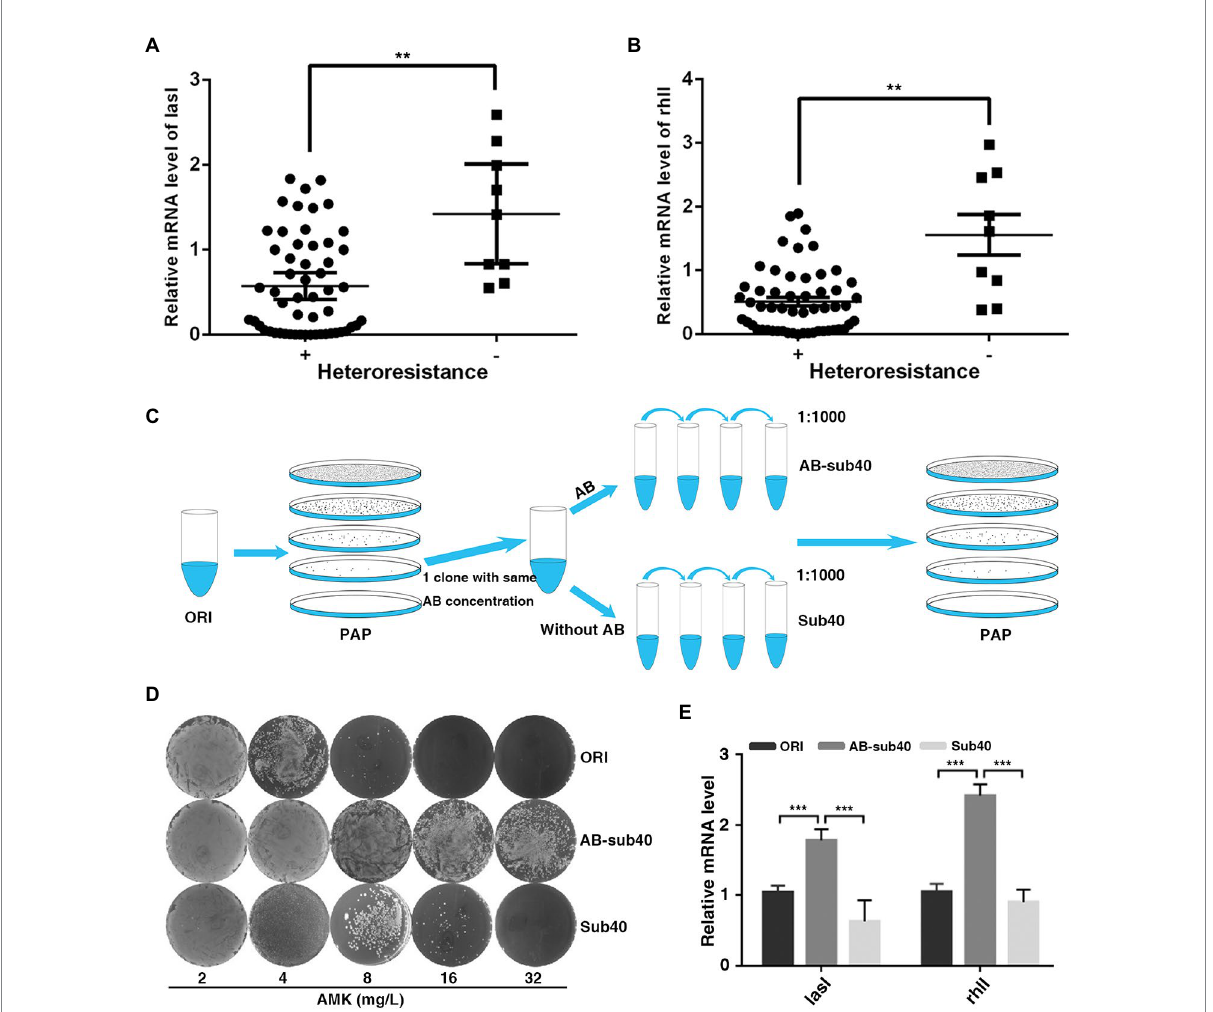
FIGURE 2 Expression of LasI and RhlI is negatively correlated with the HR of P. aeruginosa . (A,B) Expression of LasI and RhlI was lower in the heteroresistance-positive group compared with in the heteroresistance-negative group. (C) A schematic outline of the methods used to assess the stability of HR. A resistant colony from the PAPs test plates was re-streaked and grown at the same concentration of antibiotics (Enrich), followed by serial passages with or without antibiotic selection for 40 generations (1, 1,000 daily dilution). (D) After serial passages in antibiotic- free medium, resistant subpopulations reverted to the heterogeneous resistance phenotype showed by the original population. (E) The expression of LasI and RhlI in the original PAO1 (ORI), resistant subpopulations after 40 generations with or without exposure to antibiotics (AB-sub40 and sub40, respectively). **, p < 0.01; ***, p <